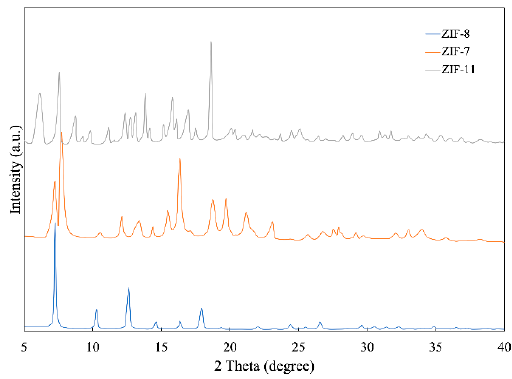
Figure 3. XRD patterns of ZIF-7, ZIF-8 and ZIF-11.